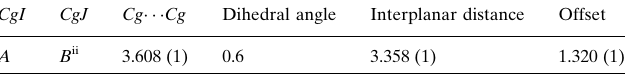
Table 2 (cid:2) – (cid:2) interactions (A˚ , (cid:2) ).